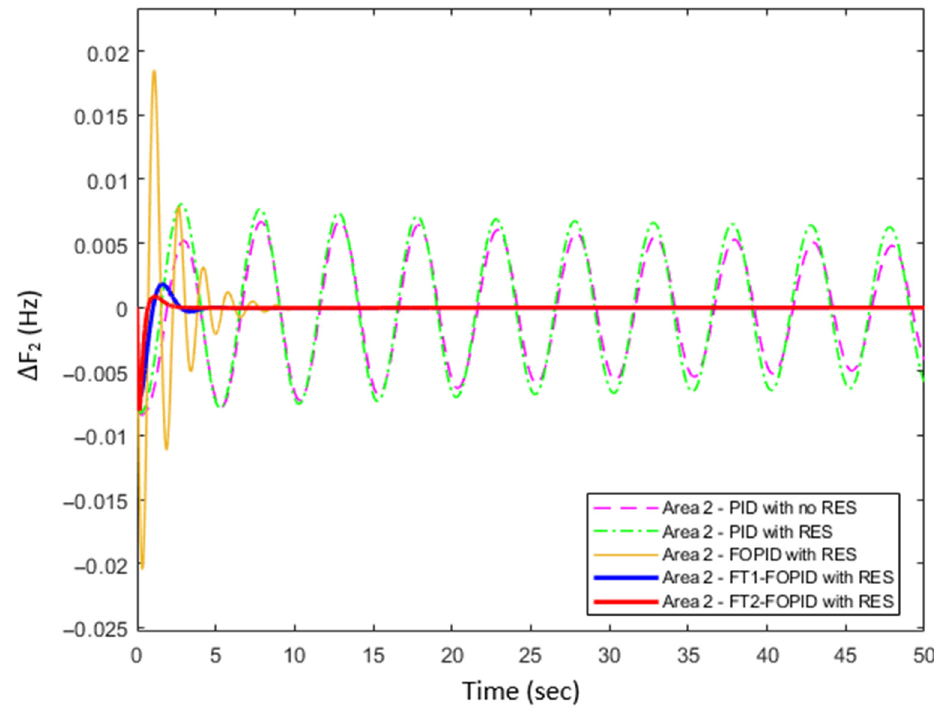
Figure 15. Results for 1% and 2% load alteration in Area 2.